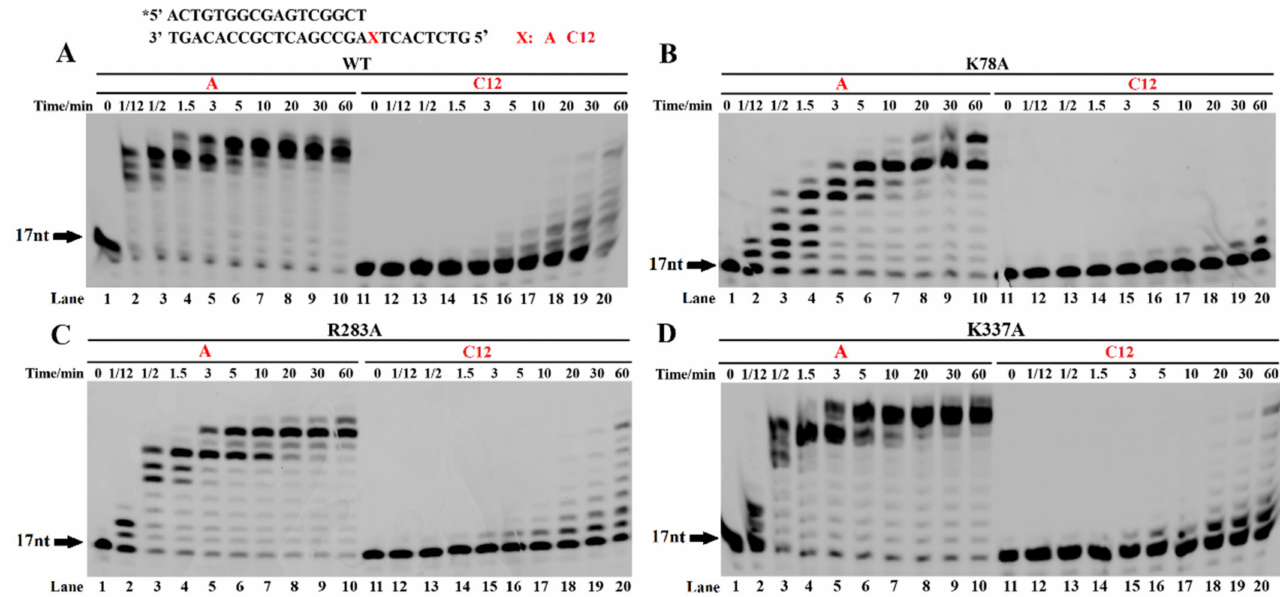
Figure 7. TLS by palm and linker mutants of Dbh. The PT DNA substrates are shown at the top of the figure, where the letter X denotes base A (normal DNA template) and spacer C12. DNA substrates were incubated with dNTPs and 0.2 µ M wt Dbh ( A ), or the mutant K78A ( B ), R283A ( C ), or K337A ( D ), at 45 ◦ C for 0, 10, 20, and 60 min. Asterisks denote the terminal fluorescent group